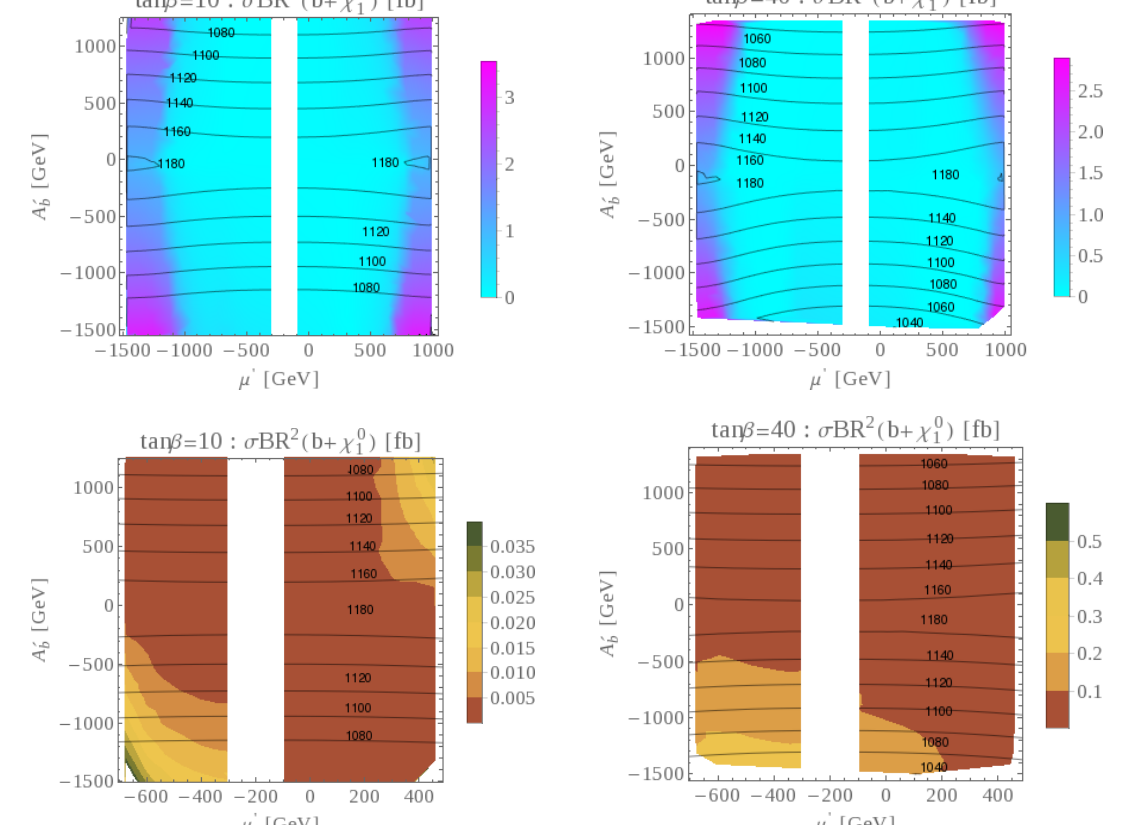
BR[~ b 0 Figure 10 . Variation of (cid:27) ~ ] 2 (yield) in the 2 b + =E (cid:12)nal state as a function of (cid:22) 0 1 ! b(cid:31) T 1 b 1 ~ b 1 (cid:2) and A 0 for (cid:12)xed MSSM con(cid:12)gurations ( (cid:22) = 200 GeV, M 1 = 500 GeV, m ~ = m ~ =1.2 TeV, A b = 0 b b L b R with tan (cid:12) = 10 (left) and 40 (right)) over an extended range of (cid:22) 0 (top panel) and for a zoomed-up range with low (cid:22) 0 (bottom panel). The blank vertical bands in the middle are roughly excluded by & 100 GeV [83]. See table 1 and searches of the lighter chargino at the LEP experiments, i.e., m (cid:6) (cid:31) 1 the text for